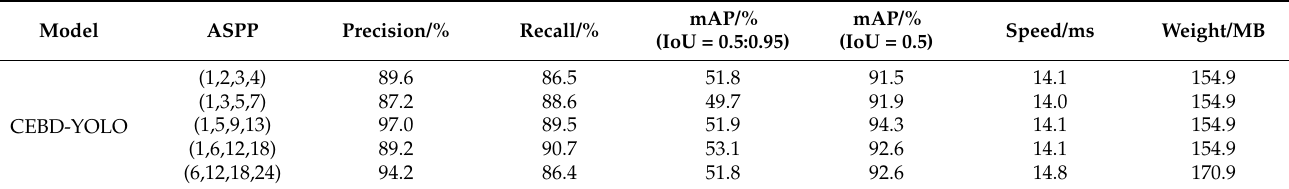
Table 6. Combination results of different expansion ratio values in